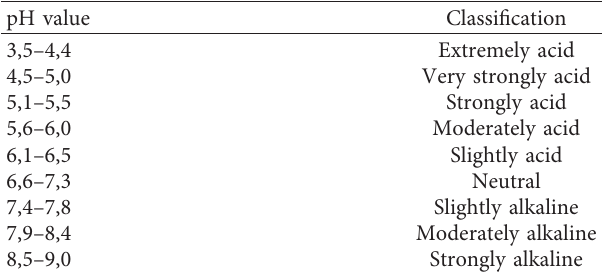
Table 3: pH Classifications by USDA.